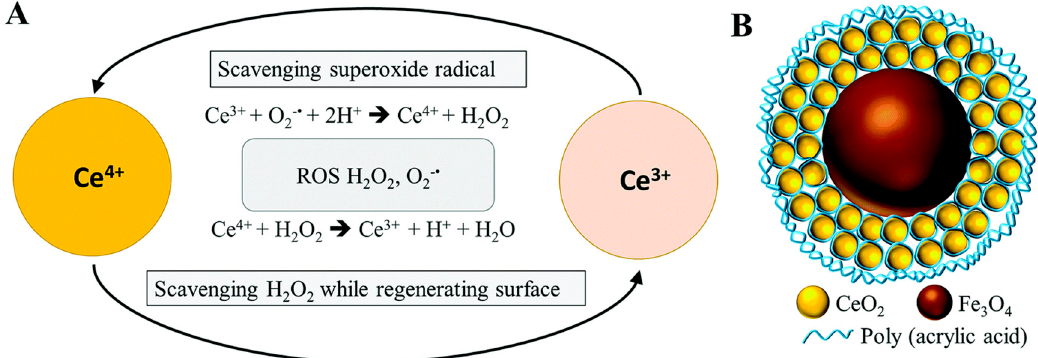
Figure 6. Regenerative antioxidant properties of cerium oxide and the simulation structure of iron oxide/cerium oxide core-shell nanoparticles. ( A ) Regenerative antioxidant properties of cerium oxide show that cerium ions are capable of scavenging superoxide radicals when trivalent cerium ions change to tetravalent cerium ions. On the other hand, cerium oxide has the ability to scavenge H 2 O 2 when tetravalent cerium ions become trivalent cerium ions. ( B ) Simulation structure of iron oxide/cerium oxide core-shell nanoparticles. Reprinted with permission from Journal of Materials Chemistry B. Wu, Y., et al., Novel iron oxide-cerium oxide core-shell nanoparticles as a potential theranostic material for ROS related inflammatory diseases, pages 4937–4951. Copyright 2018 Royal Society of Chemistry [77].